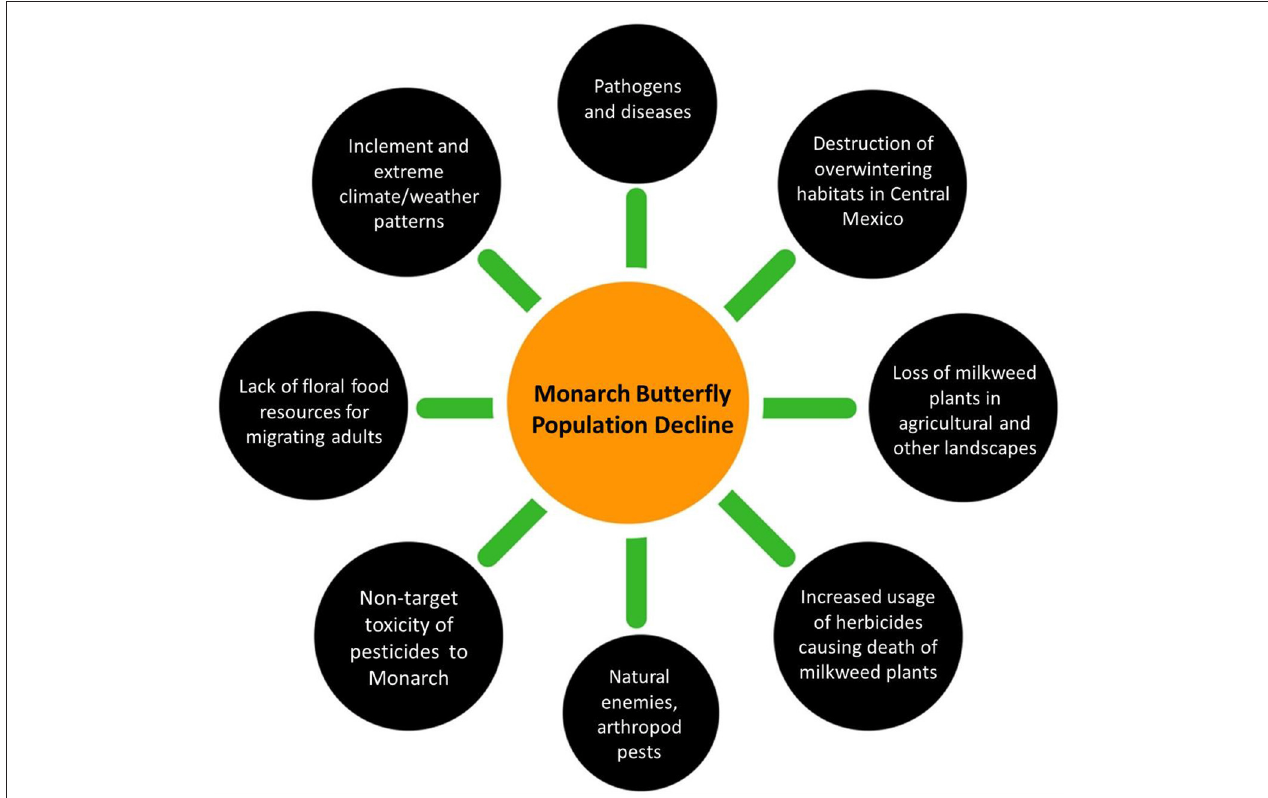
FIGURE 1 | Different factors affecting monarch butterfly population in North